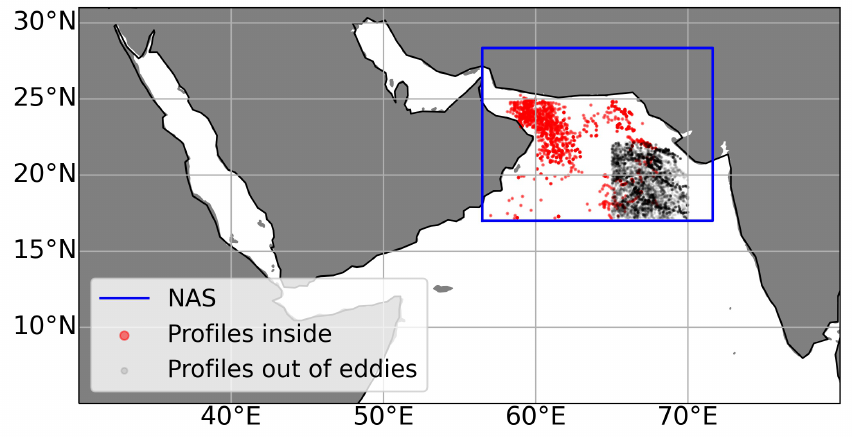
Figure 3. Distribution of the inside/outside eddy profiles in the NAS region, which includes the Gulf of Oman and the northern part of the Arabian Sea (called area D).